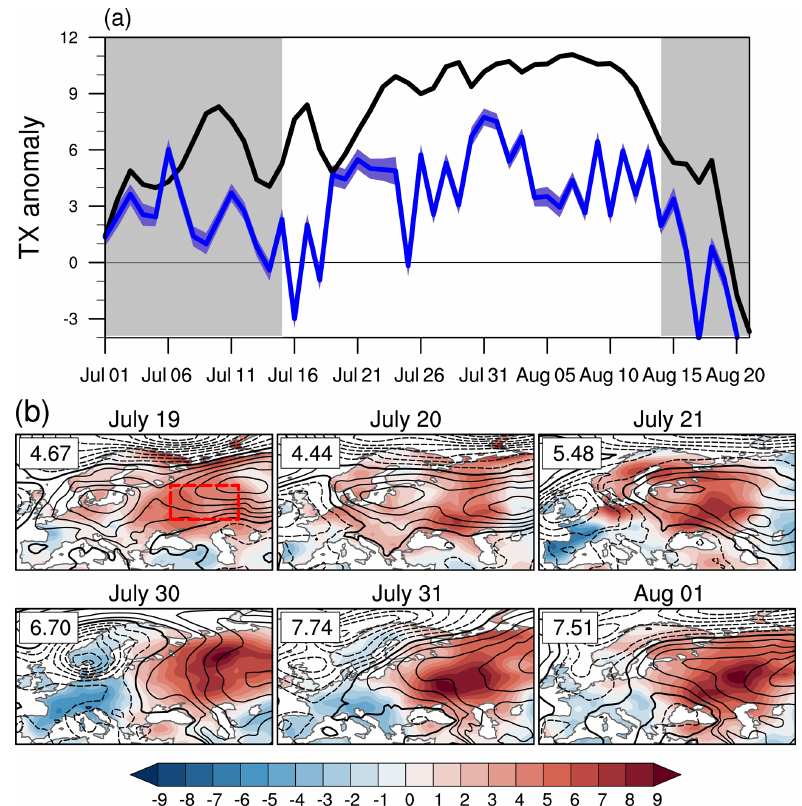
Figure 4. (a) Time evolution of BERK daily maximum temperature ( ◦ C) anomaly averaged over the western Asia domain (box with red dashed line in b ). The covered period is from 1 July until 20 August 2010. The thick black line represents the total TX anomaly. The thick blue line shows the contribution of the dynamic component, and the blue shading indicates the 95% confidence interval of the reconstruction based on bootstrapping (see Sect. 2.2). The chosen period for the Russian heat wave is defined by the white background. (b) Daily maps of SLP anomaly (hPa, black line contours with contour interval of 1hPa) and of the dynamic component contribution ( ◦ C, shading) to the total TX anomaly. The thick black contour line indicates the zero SLP anomaly and dashed contour lines indicate negative SLP anomalies. Numbers in the upper left corner indicate the region-averaged contribution of the dynamic component to the total TX